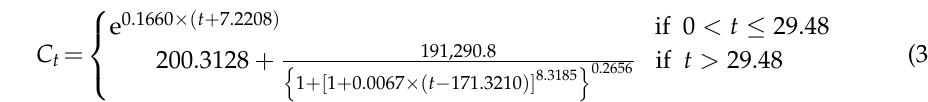
Deaths Table notes: DS, Deviance statistic; DF, Degrees of freedom; r 2 hood Ratio